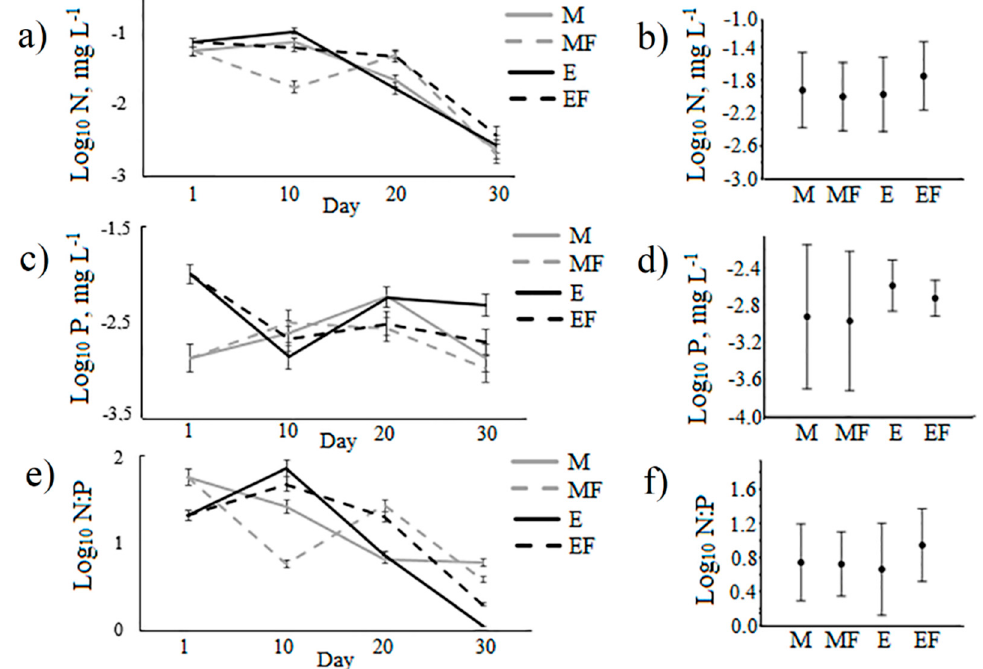
Figure 2. Dynamics of nutrient concentrations in the experiment ( a , c , e ) and treatment means ( b , d , f ); M—mesotrophic conditions, MF—mesotrophic conditions with introduced fish, E—eutrophic conditions, EF—eutrophic conditions with introduced fish.